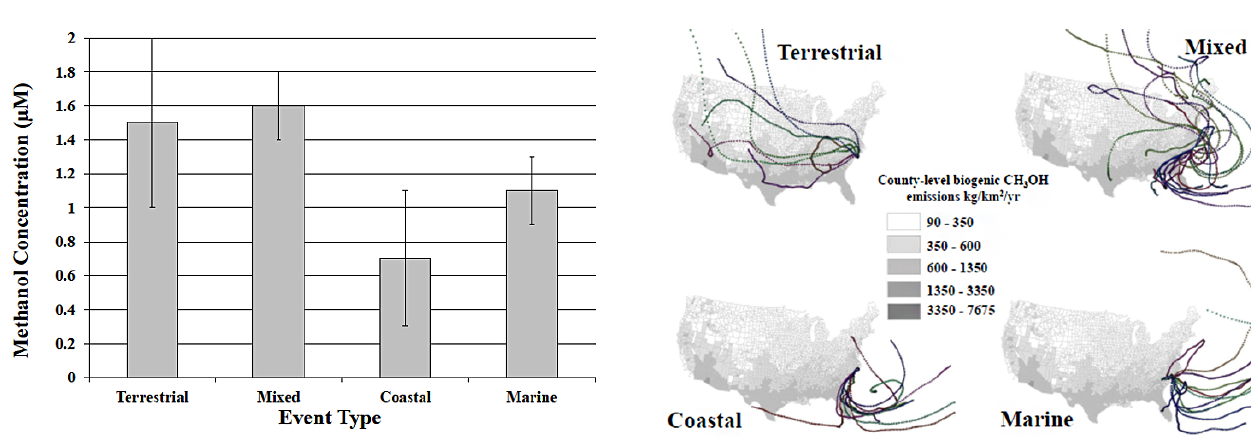
Figure 2. Rain event trajectories plotted over annual county-level biogenic methanol emissions that have been normalized by county size. Methanol emission in kgkm − 2 yr − 1 .